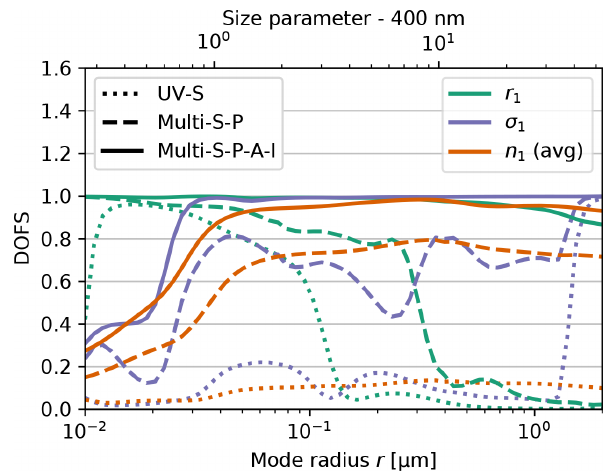
Figure 6. Dependence of DOFS on aerosol VCD for different mea- surement modes. For the detailed settings, see the main text.